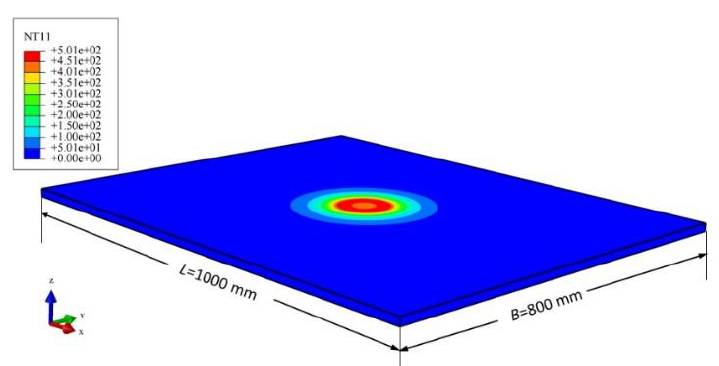
Figure 6. The finite element result of the heat transfer calculation.